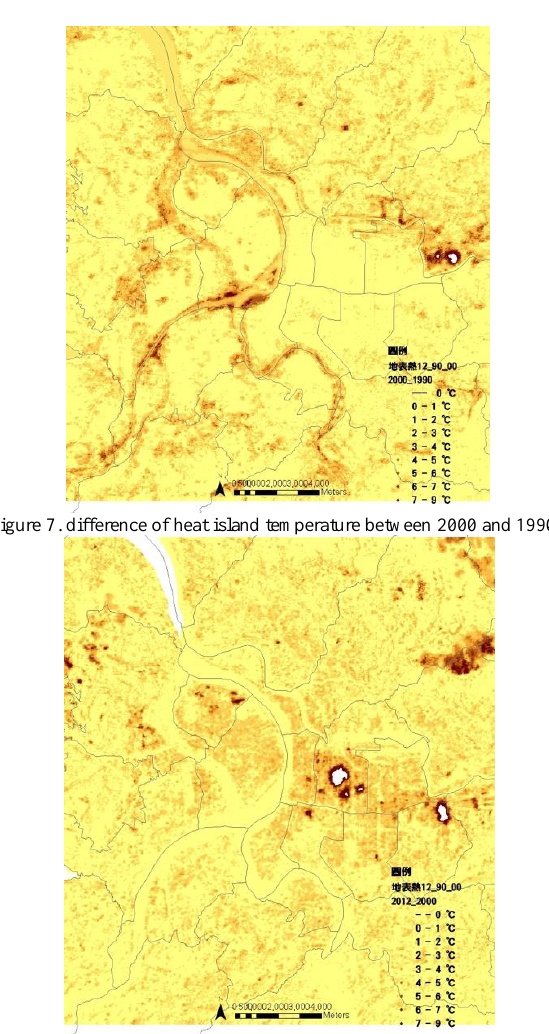
Figure 8. difference of heat island temperature between 2015 and 2000